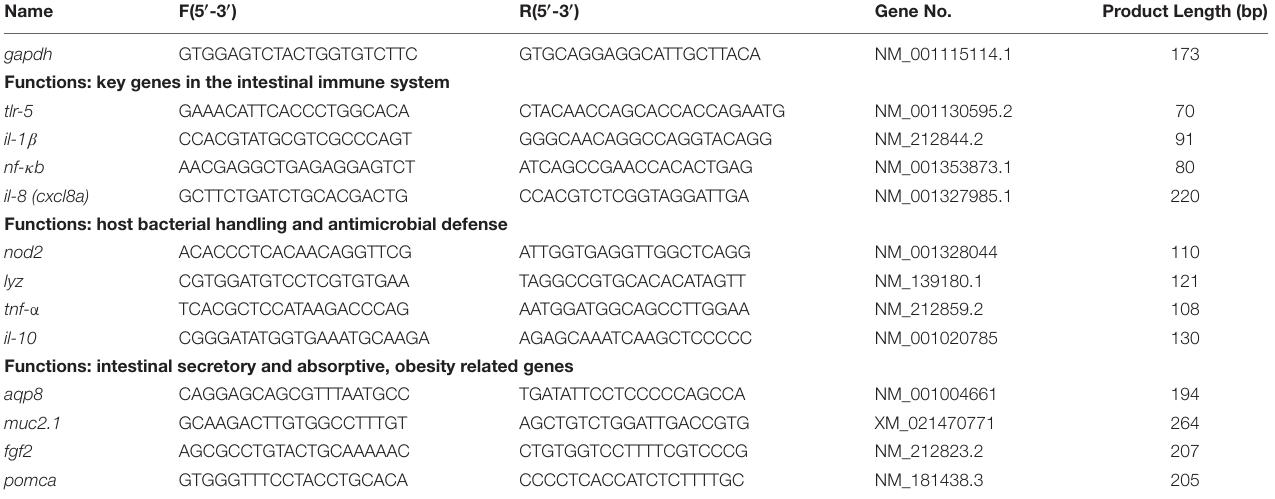
TABLE 1 | The primers of related genes in zebrafish in this